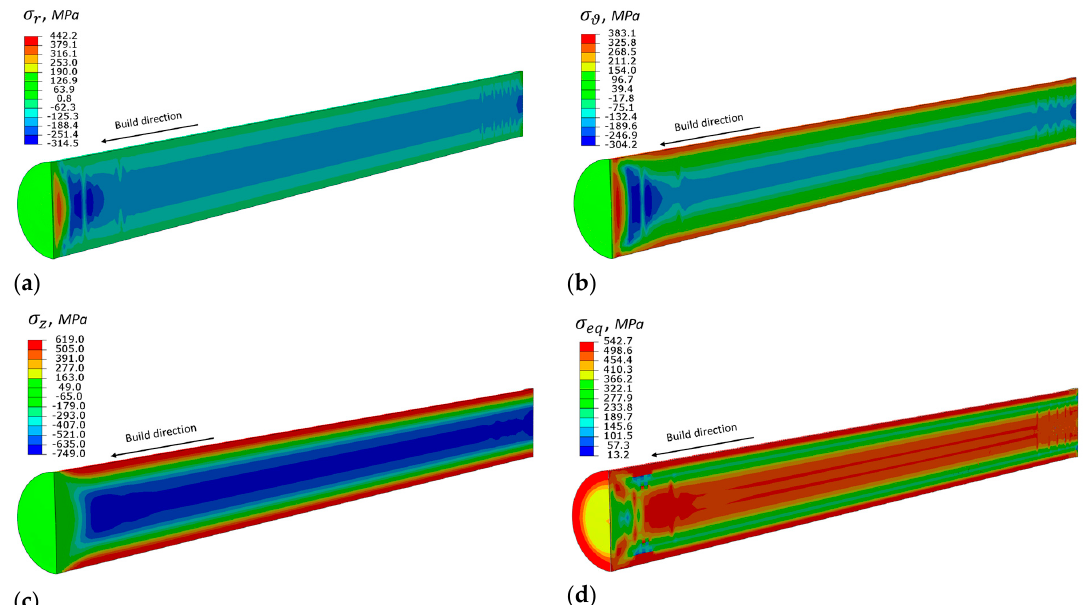
Figure 10. Residual stress distribution in as-build cylindrical rod before cut (MPa). ( a ) radial component, ( b ) circumferential component, ( c ) axial component along build direction, ( d ) von Mises equivalent stress.